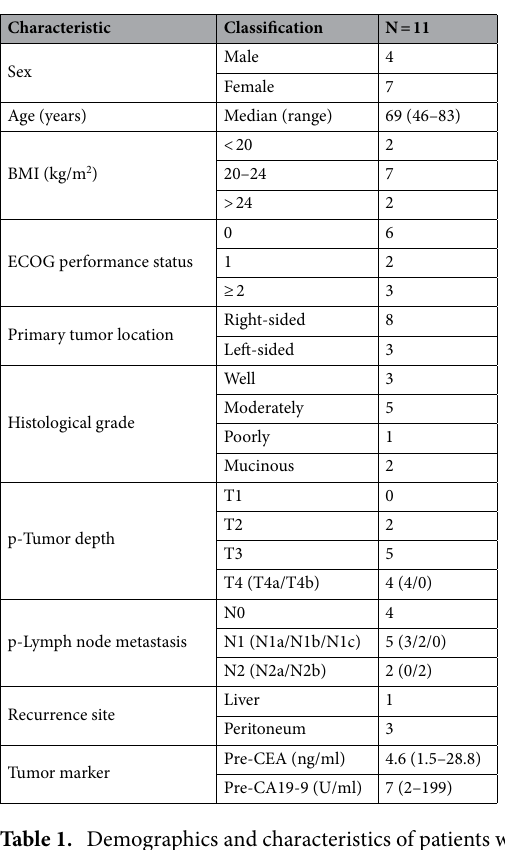
Table 1. Demographics and characteristics of patients with BRAF V600E mutation. BMI body mass index, ECOG Eastern Cooperative Oncology Group.